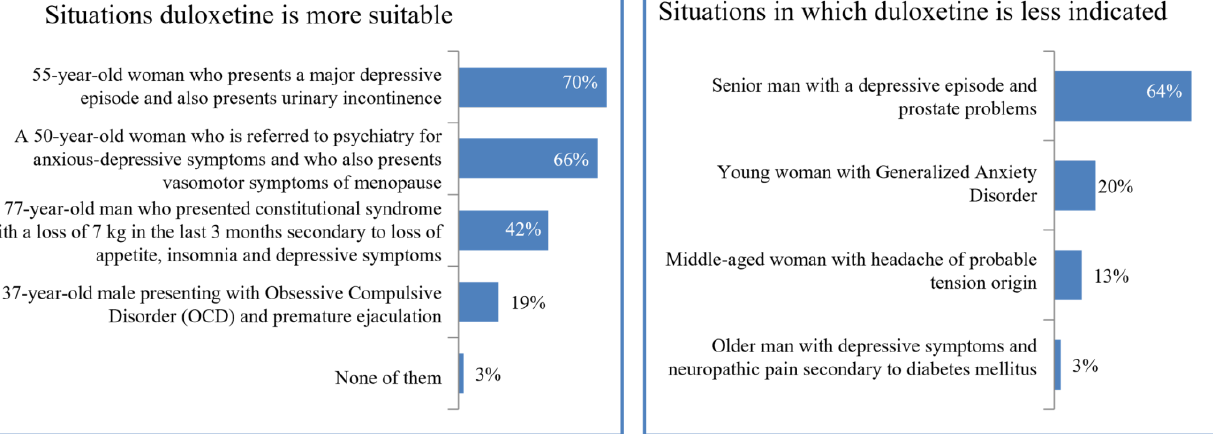
Figure 3. Situations for which duloxetine is the most and the least recommended antidepressant according to the doctors surveyed. 4. Discussion